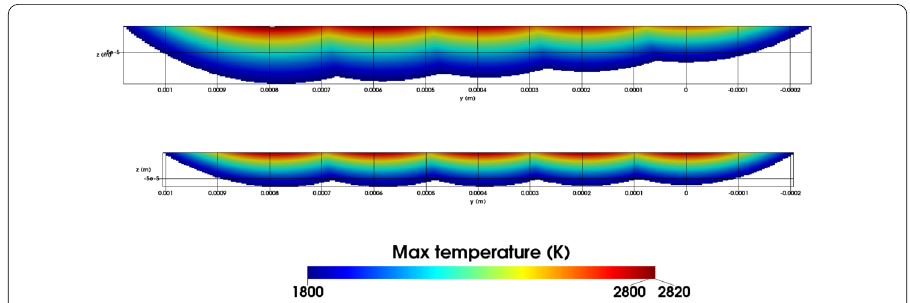
Figure 8 A comparison between maximum temperatures in the cross-section x = 2.5 mm before optimization (top) and after optimization. Initially, the melt area increases for each hatch line since the heat influx is larger than the rate of diffusion. The optimization scheme resolves this issue and makes the area more uniform.